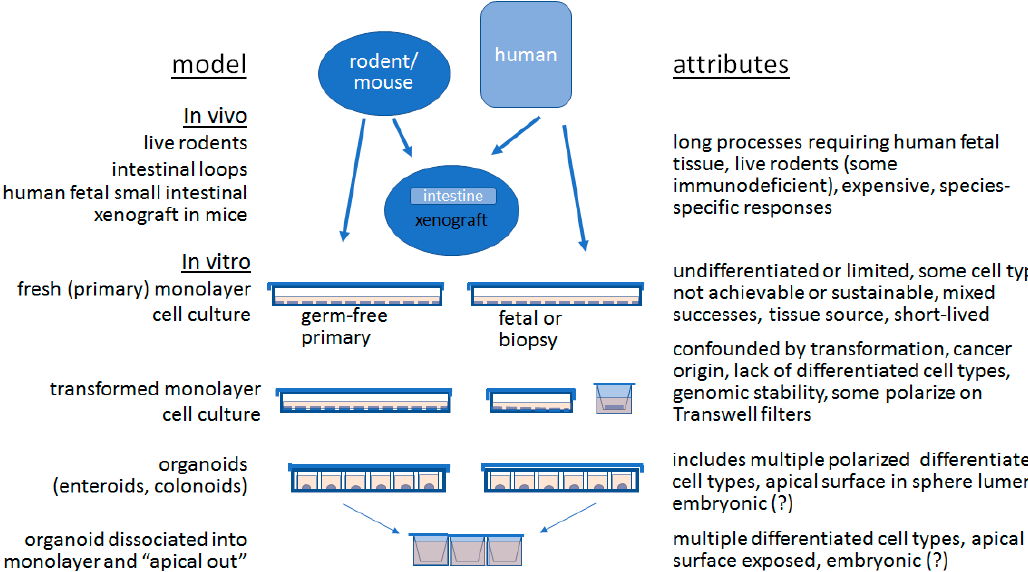
Figure 1. Attributes of popular model systems for studying intestinal epithelial cells, depicted as evolving with improving refinement in ex vivo cell resemblance to native epithelium.